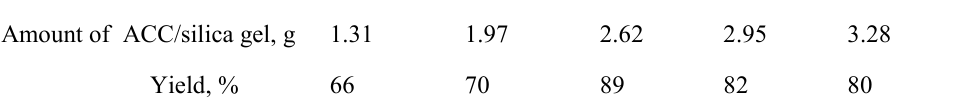
Table 1 The effects of the amount of ACC/silica gel on the oxidation of cyclohexanol to adipic acid under ultrasound irradiation*